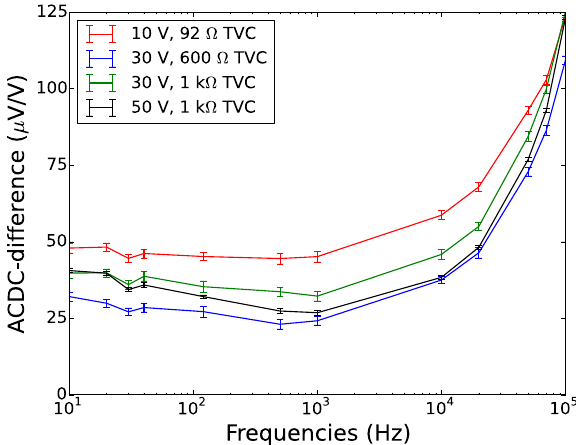
Fig. 8. Resulting ac – dc difference for the divider and buffer combination from 10 Hz up to the maximum capability of the calibrator. Red curve contains the measurements for 10 V, blue curve contains the measurements for 30 V, and black curve contains the measurements for 50 V. The green curve contains the measurements for 30 V, by using the references used for 50